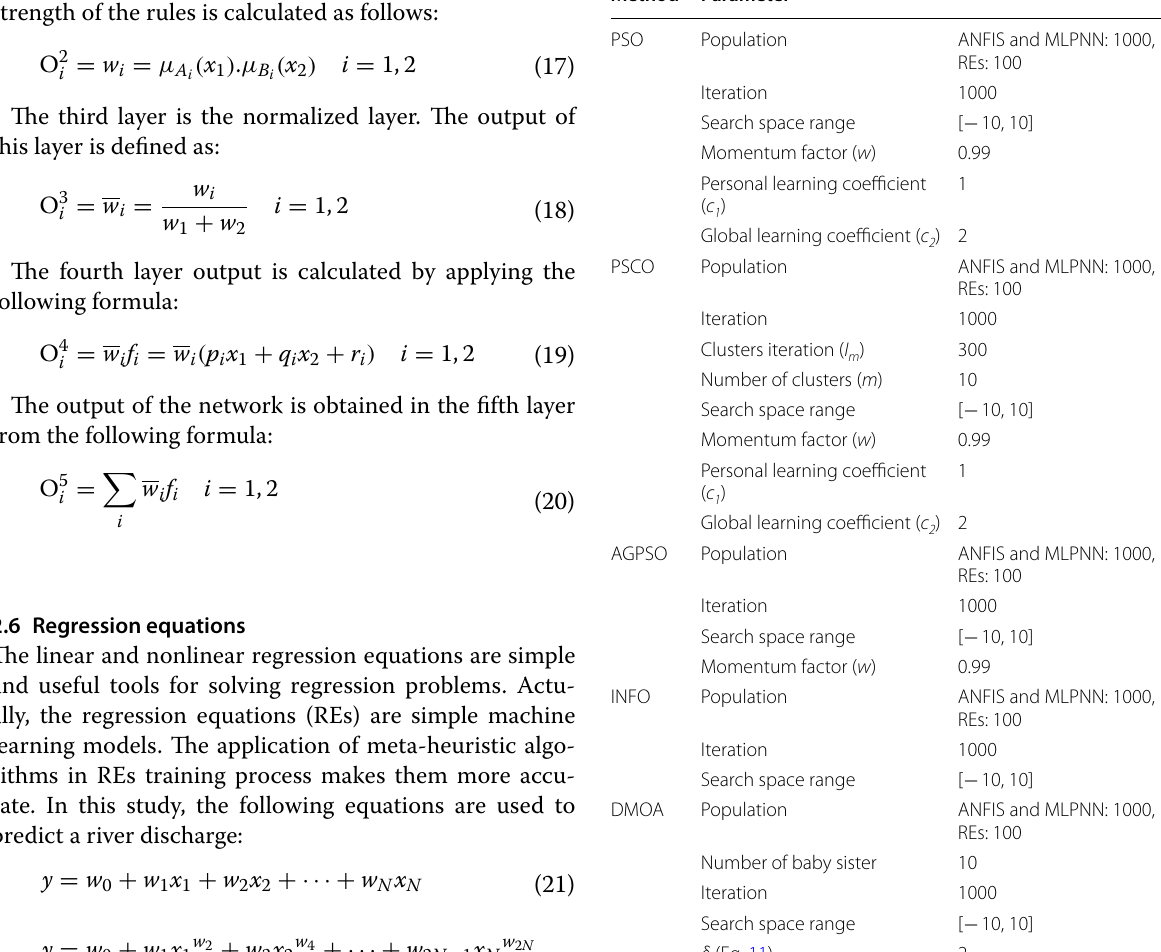
Table 1 The initial values of PSCO and PSO Method